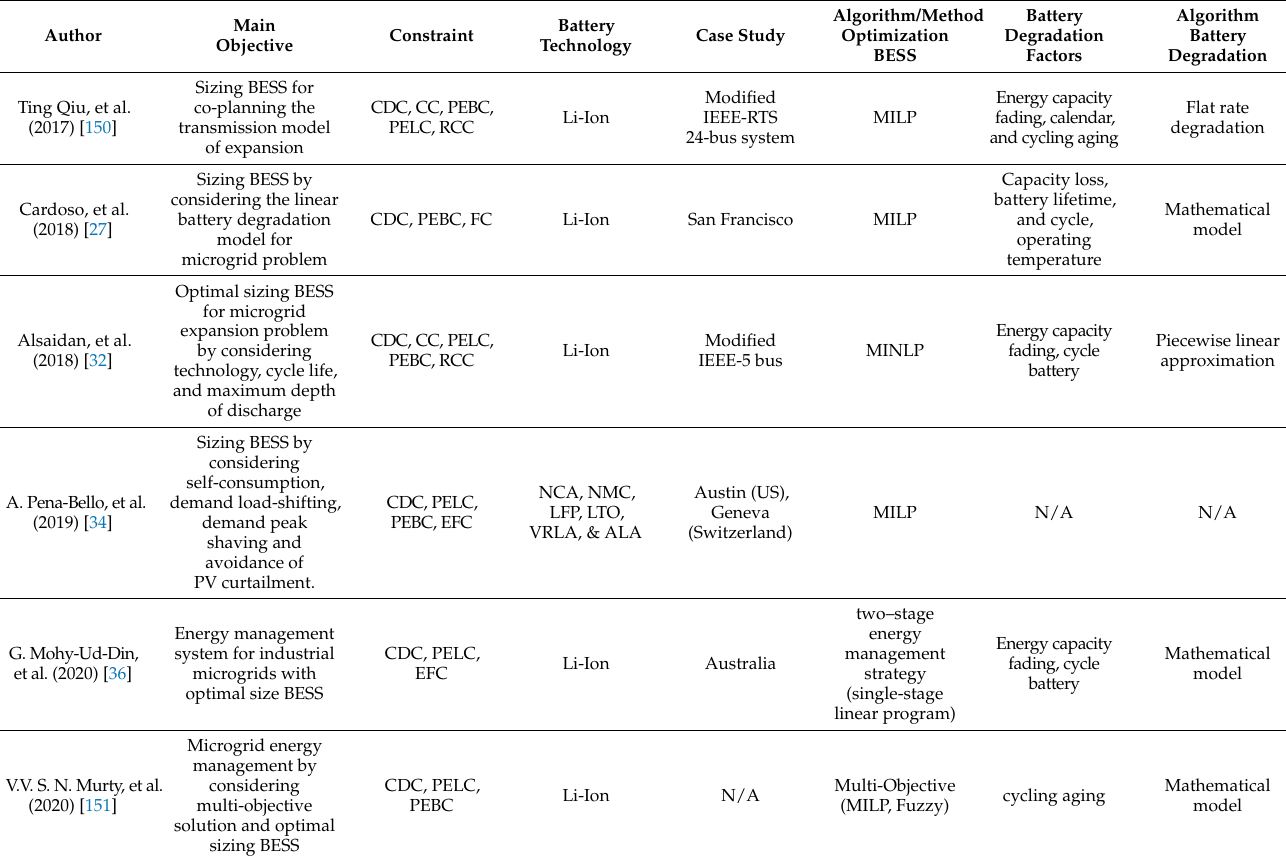
Table 11. Literature review of studies of the BESS optimization effect considering battery